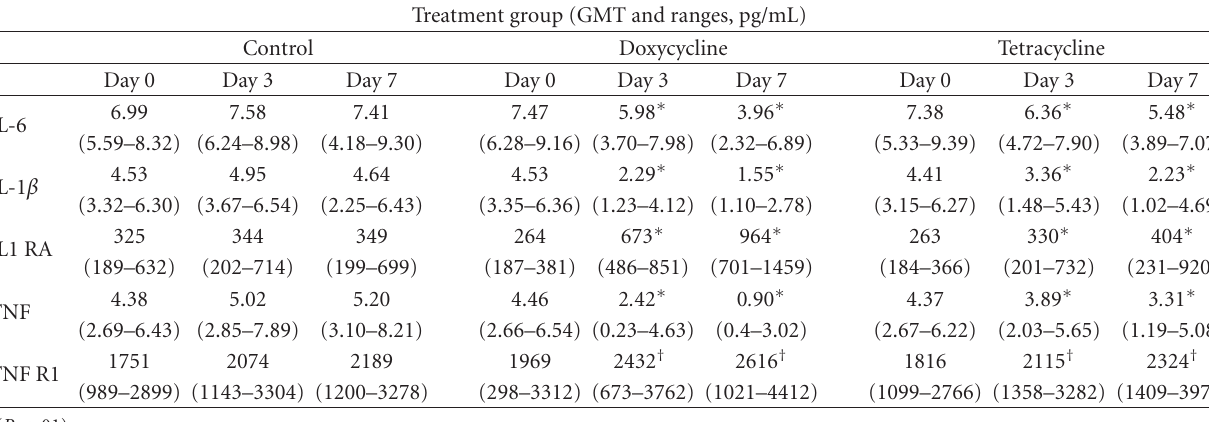
Table 1: E ff ect of Doxycycline and Tetracycline on cytokine levels and IL1-RA and S TNF-R1 in patients with dengue fever.